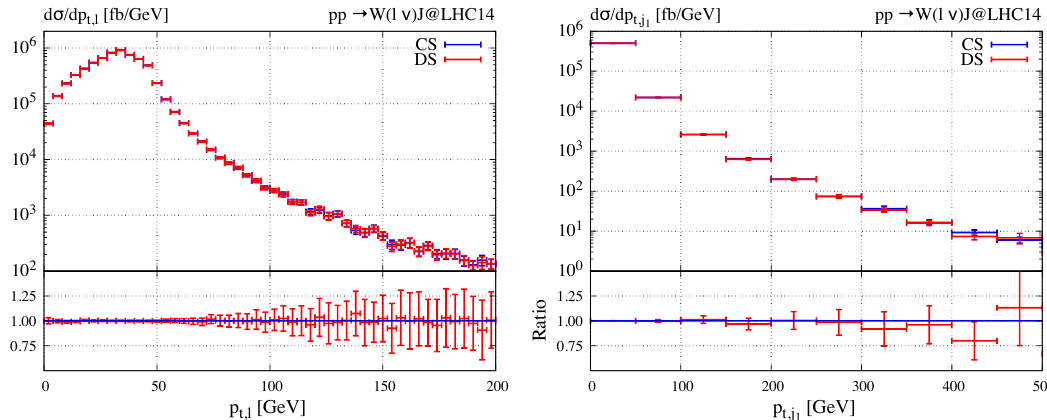
Figure 9. Charged lepton (left) and hardest jet (right) transverse momentum distributions for W + plus 1 jet production in proton-proton collisions at 14 TeV center-of-mass energy ( q ¯ q -channel only). The renormalization and the factorization scale are both equal to µ = 80 GeV. The Dual Subtraction (DS) results are shown in red, while the Catani-Seymour (CS) ones in blue. The error bars correspond to the statistical error given by the Monte Carlo